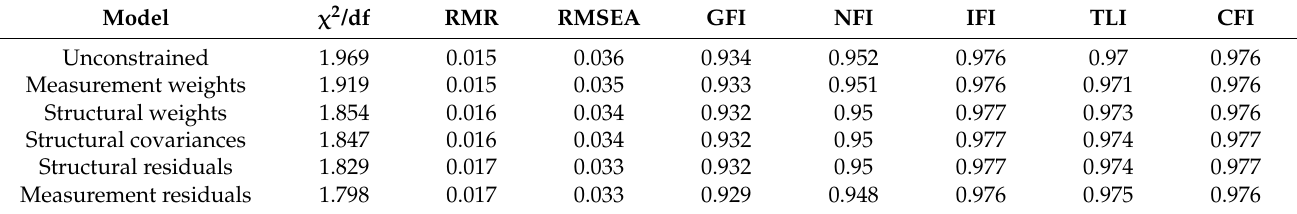
Table 6. Goodness of fit indices for all tested models.